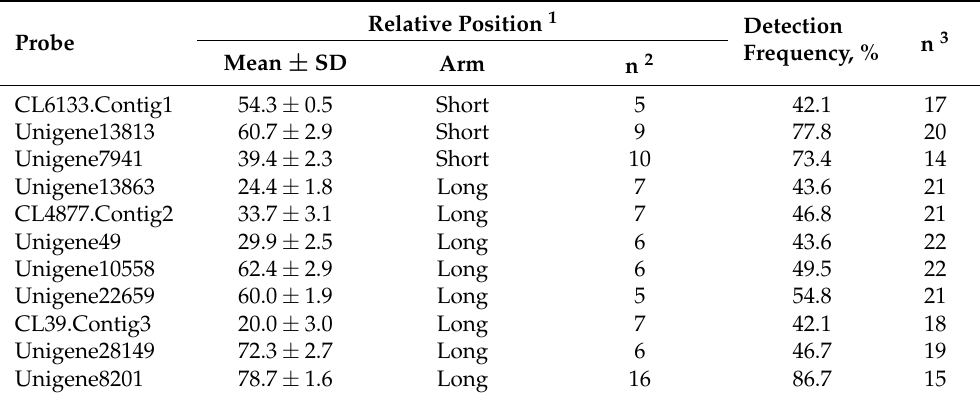
Figure 3. Dual-color Tyr-FISH on mitotic chromosomes 6 of Allium cepa probing with CL6133.Contig1 (green) and Unigene13813 (red). Scale bar—10 µ m. Table 3. Relative positions and detection frequencies of Tyr-FISH signals from molecular markers on mitotic metaphase chromosome 6 of